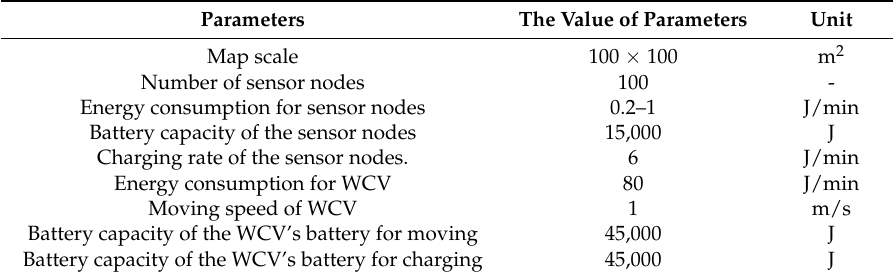
Table 5. The parameters of